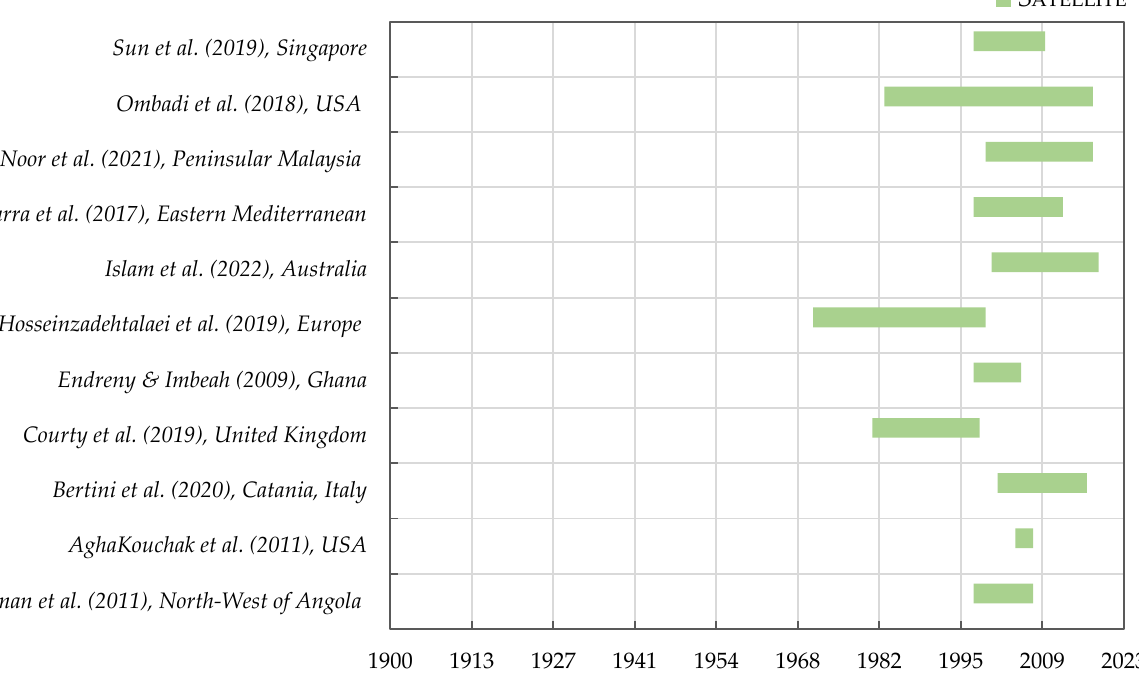
Figure 5. Years of coverage for each satellite dataset Table 4. Papers developing IDFs using a satellite dataset.